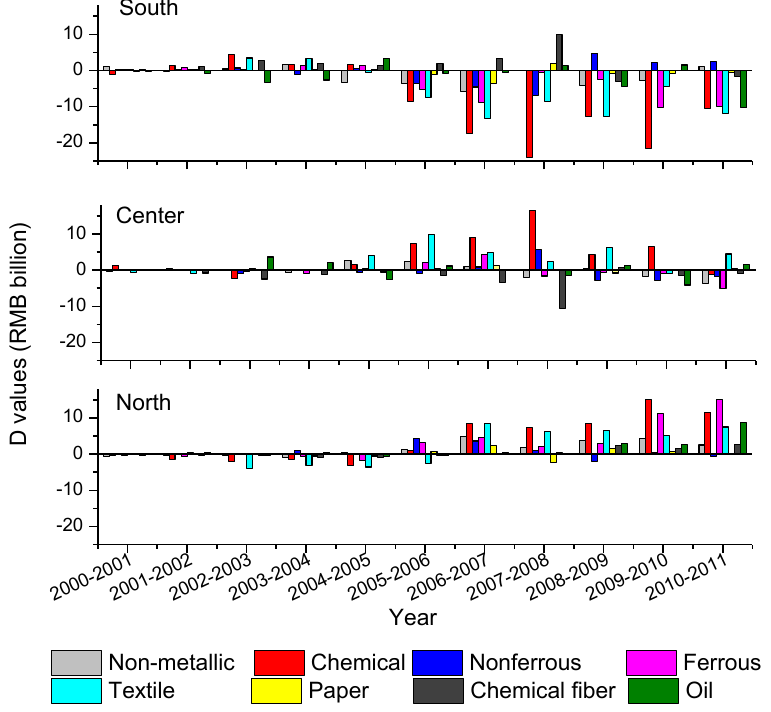
Figure 6. D values in individual subsectors in the three regions during 2000–2011.